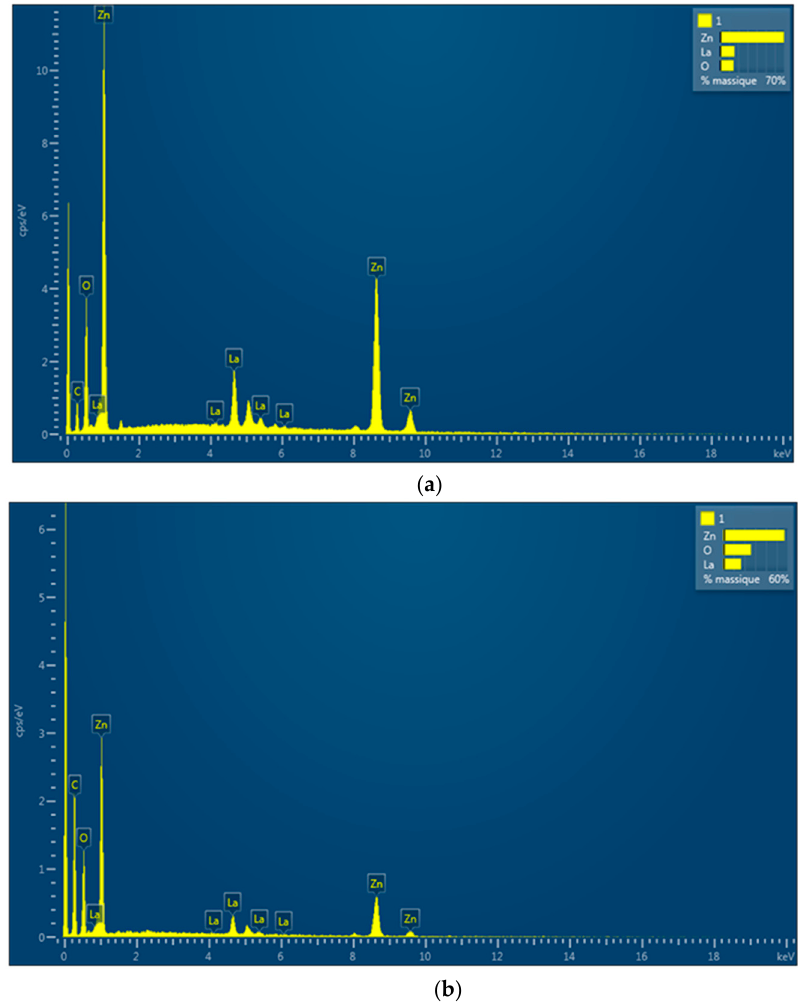
Figure 4. Energy Dispersive X-ray spectroscopy (EDS) analysis of the samples. ( a ) Zn4La (Zn:La = 1:0.1384); ( b ) - Zn4La400 (Zn:La = 1:0.1057).